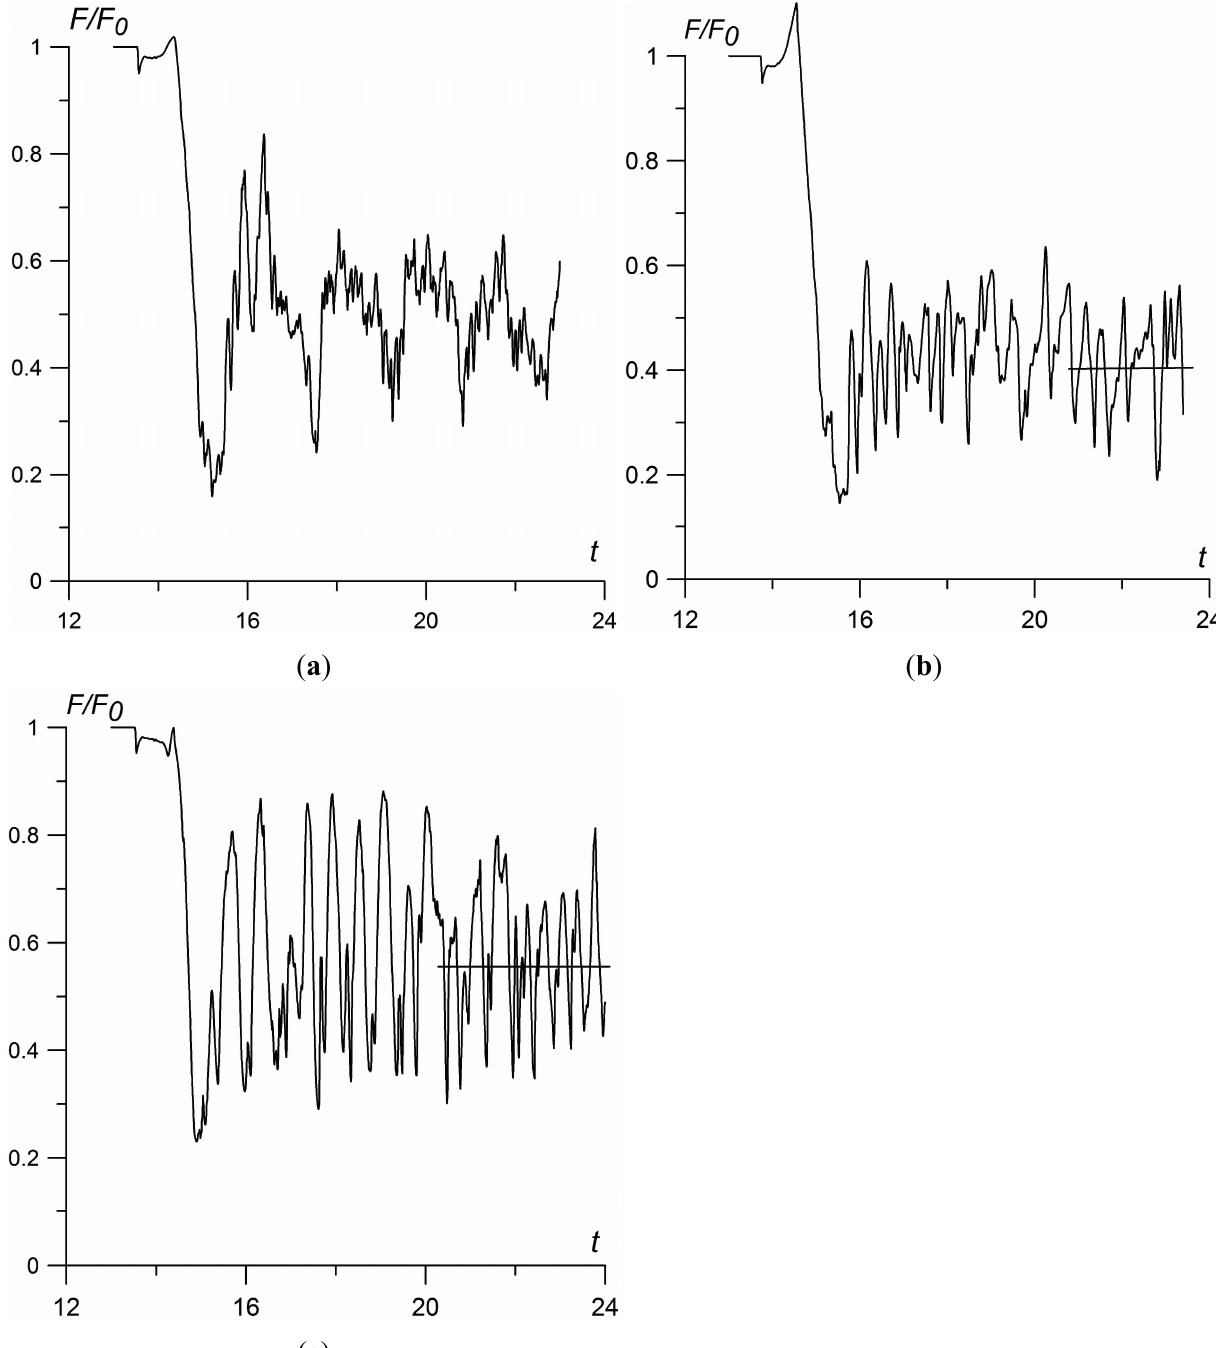
Figure 6. Dynamics of dimensionless frontal drag force, M = 1.89, α ρ = 0.5: ( a ) Non-combined filament; ( b ) Combined filament, α ρ 1 = 0.4; ( c ) Combined filament, α ρ 1 =